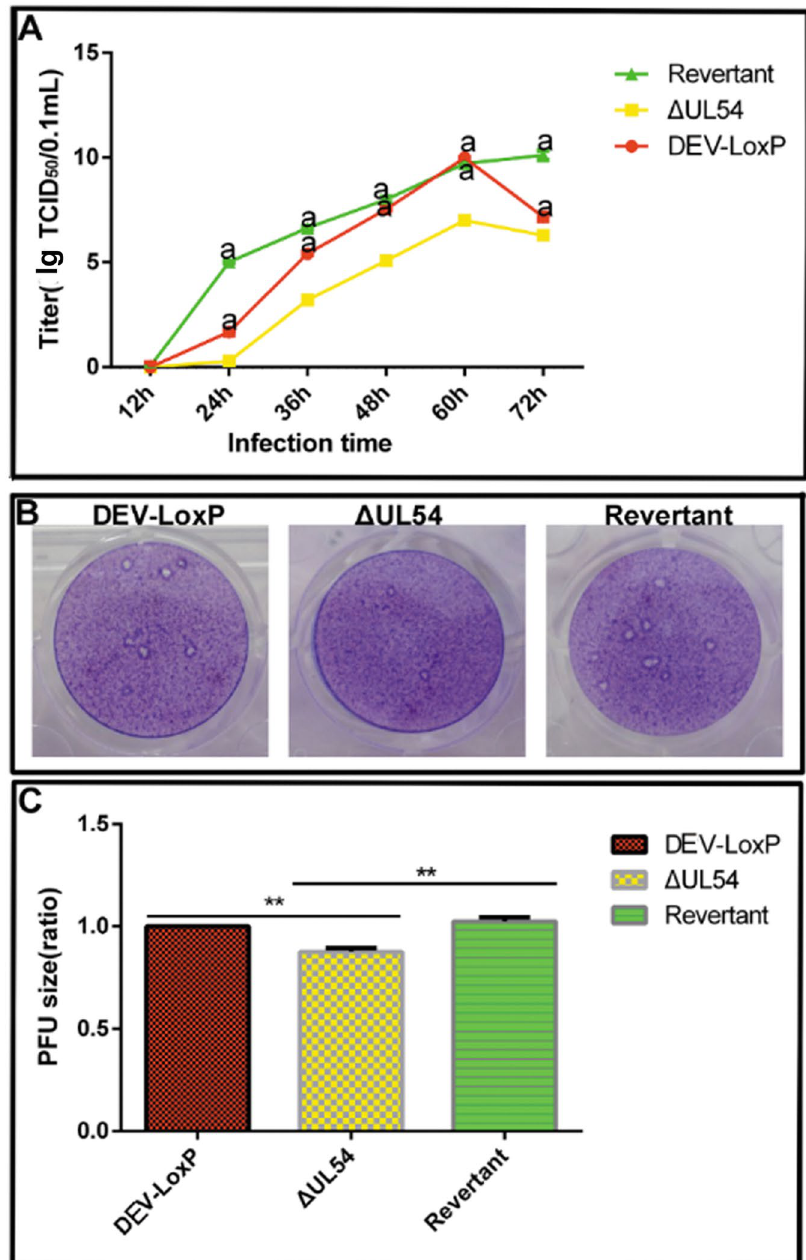
Figure 2. Growth curve and plaque size of the DEV-derived viruses. ( A ) Growth curve. DEFs were infected with DEV-LoxP, DEV- Δ UL54 or DEV- Δ UL54 (Revertant) at a titer of 200 TCID 50 and harvested at different time points. The curve was generated based on the titers of different harvests by testing TCID 50 . a: p < 0.05. ( B ) Phenotypes of viral plaques. Plaques were formed on DEFs under a semi-solid medium overlay containing methylcellulose. After fixation, crystal violet staining was performed. ( C ) Analysis of the plaque area. The mean areas of plaque were analyzed using IPP 6.0. ** p <